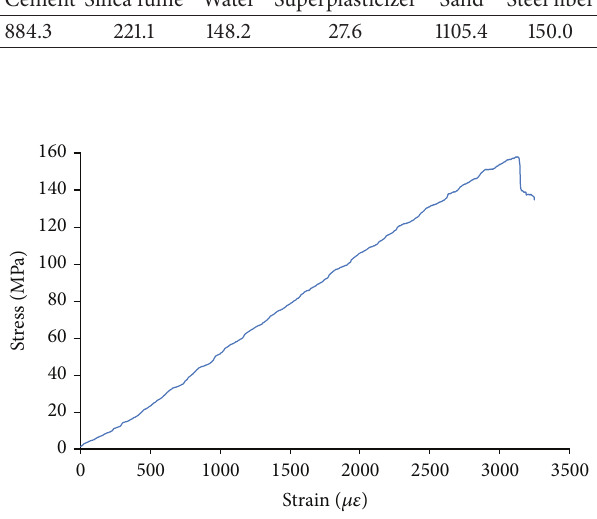
Figure 1: Compressive stress-strain curve of RPC200 ( 𝑅 ).